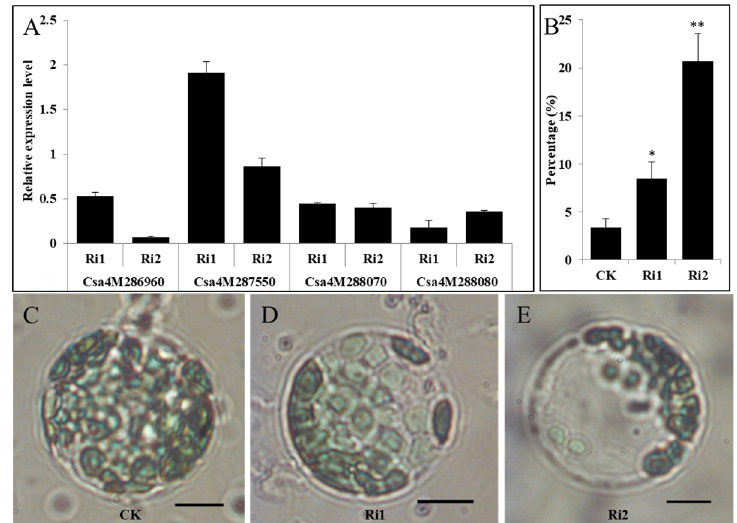
Figure 4. RNAi transient silencing of tandem 13-lipoxygenase genes in cucumber cotyledons. ( A ) Transient gene expression of tandem 13-lipoxygenase genes in cotyledons infiltrated with agrobacterium. The expressions of each sample infiltrated with RNAi (Ri1 and Ri2) were compared with that of the sample infiltrated with empty vector (CK) after normalization to the cucumber ubiquitin gene and presented as relative expression. ( B ) Quantitative proportion of protoplasts with abnormal chloroplast number in cotyledons infiltrated with agrobacterium. For each biological replicate, 50 protoplasts were counted, and an abnormal protoplast harbored less than 15 chloroplasts. Error bar indicates standard error. * stands for significant di ff erence ( p < 0.05), ** stands for significant di ff erence ( p < 0.01). ( C – E ) Chloroplast morphology of the representative protoplasts isolated from CK and Ri. Scale bar = 10 µ